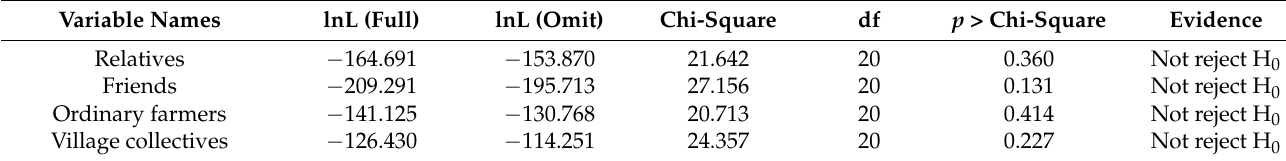
Table 7. Estimation results of Small-Hsiao